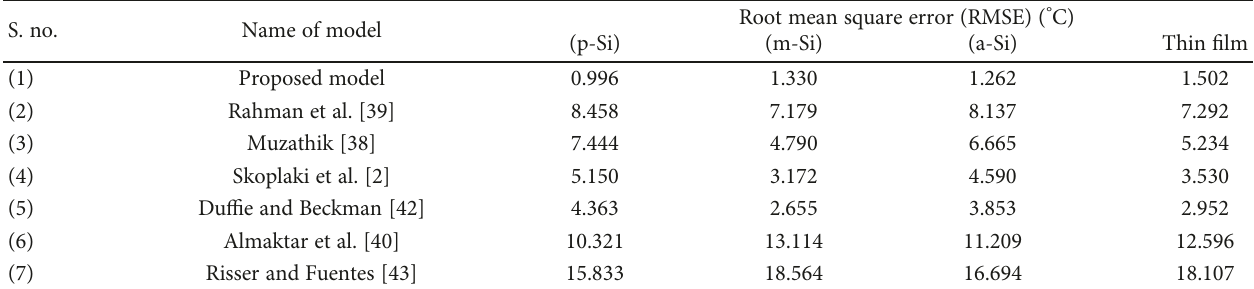
Table 10: Root mean square error (RMSE) of each PV module in summer. S. no.